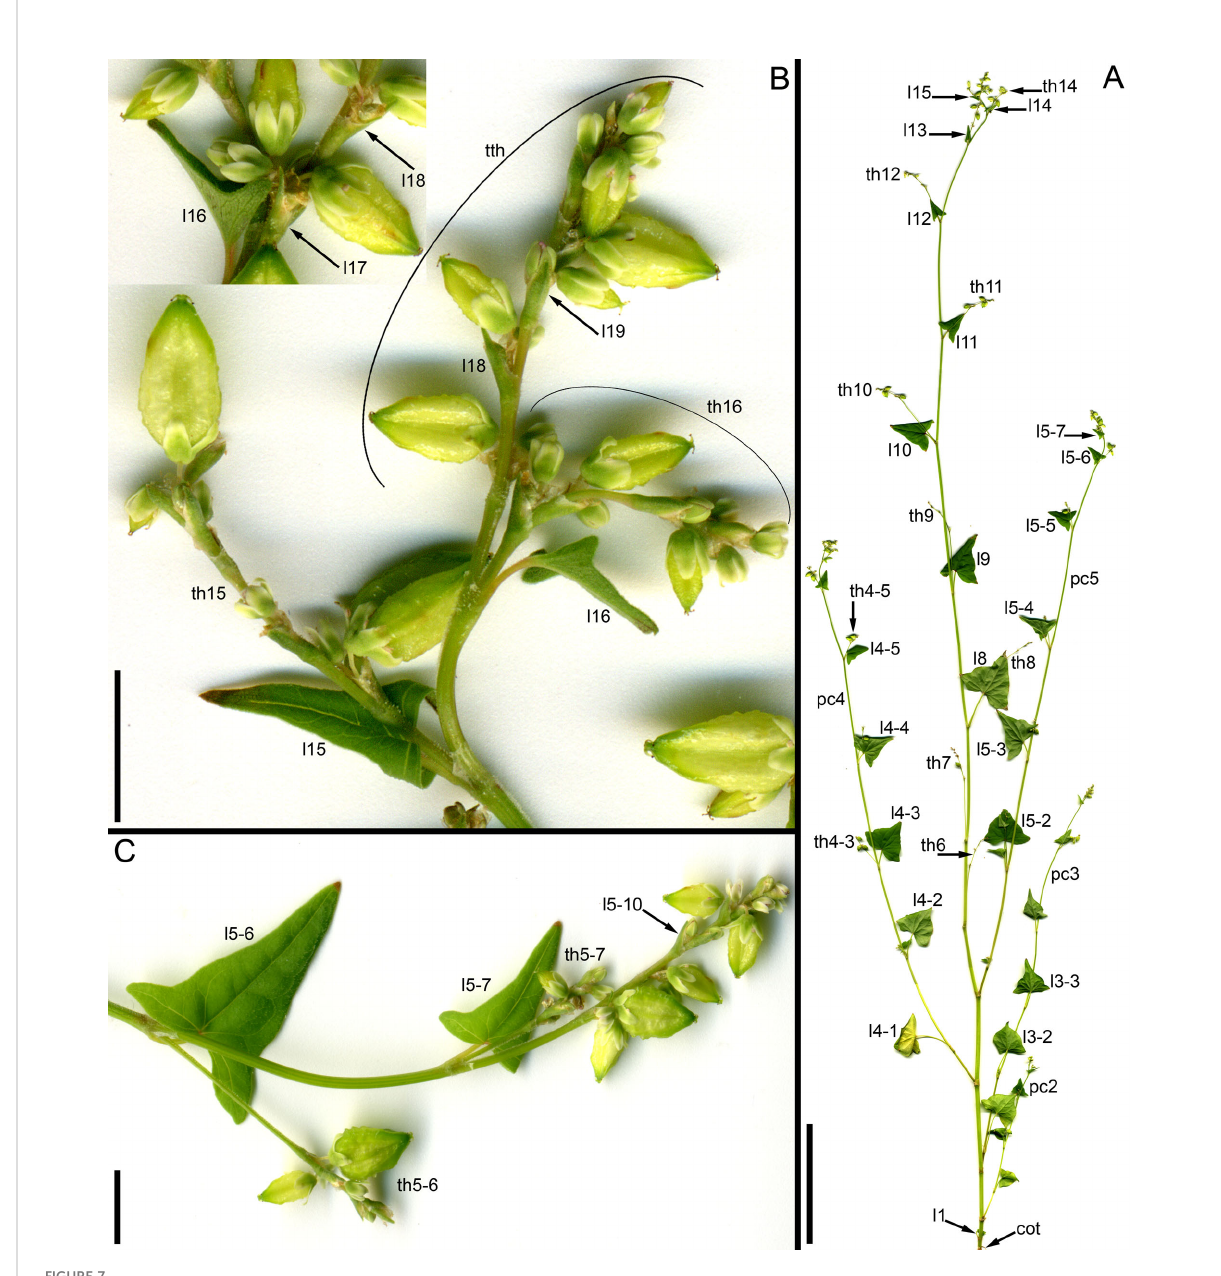
FIGURE 7 Morphology of Fagopyrum tataricum , accession C9119. (A) Entire plant. Its diagram is provided in Figure 5B. (B) Detail showing a terminal thyrse of the terminal fl owering unit and two uppermost lateral thyrses. (C) Detail showing a terminal thyrse of the uppermost paracladium and two lateral thyrses below it. cot, cotyledonary node; l, leaf (foliage leaf or cyme-subtending bract); pc, paracladium; th, lateral thyrse; tth, terminal thyrse. Leaves of the main axis are numbered (cotyledons not counted). Leaves of lateral axes have double numbers, the fi rst one being the number of the main axis leaf subtending the branch. Numbers of axillary paracladia and thyrses are those of their subtending leaves. Scale bars = 10 cm (A) , 5 mm (B, C)